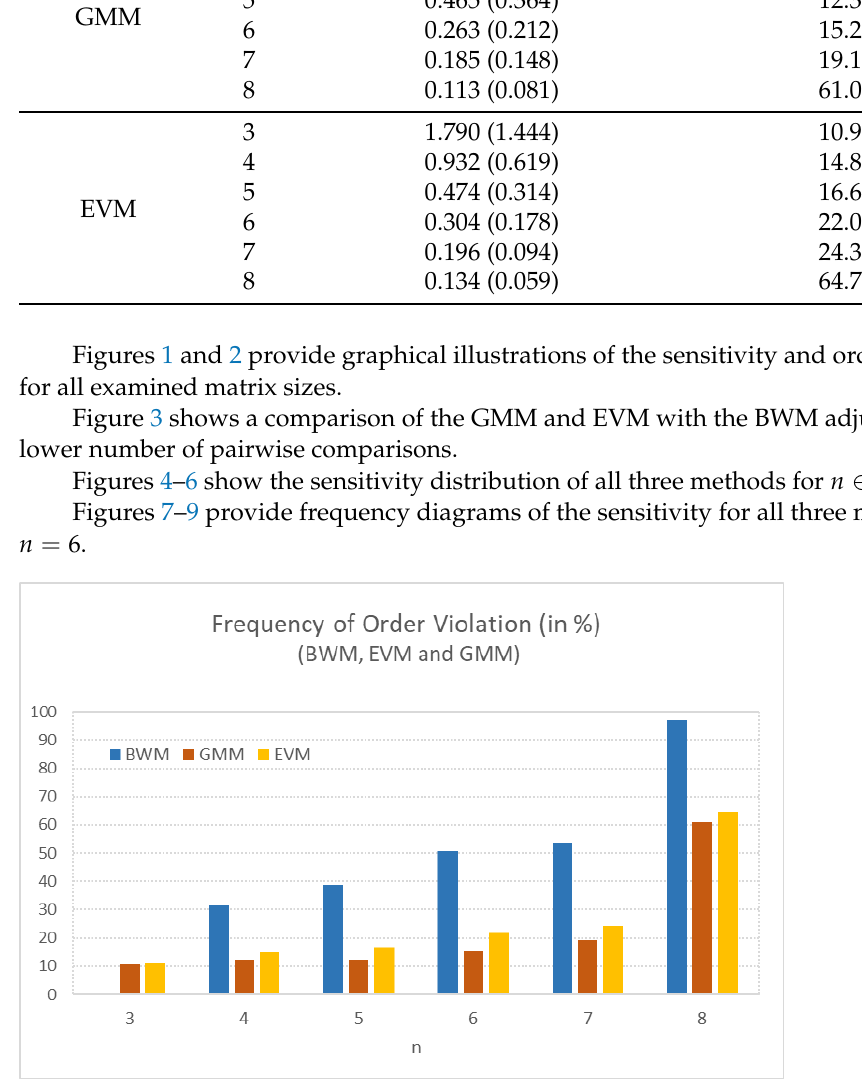
Figure 1. Average order violation: BWM, EVM, and